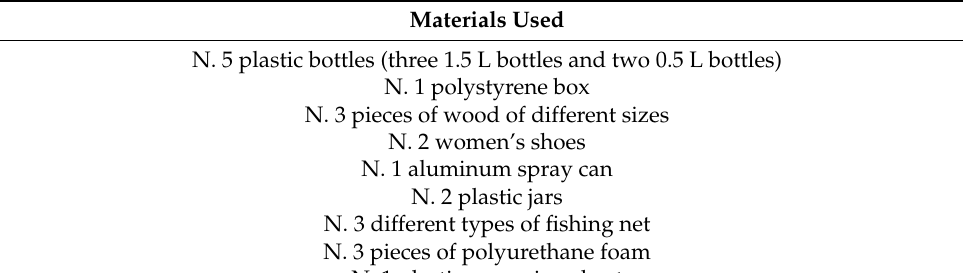
Table 2. Materials used to assemble the basic SGI module.